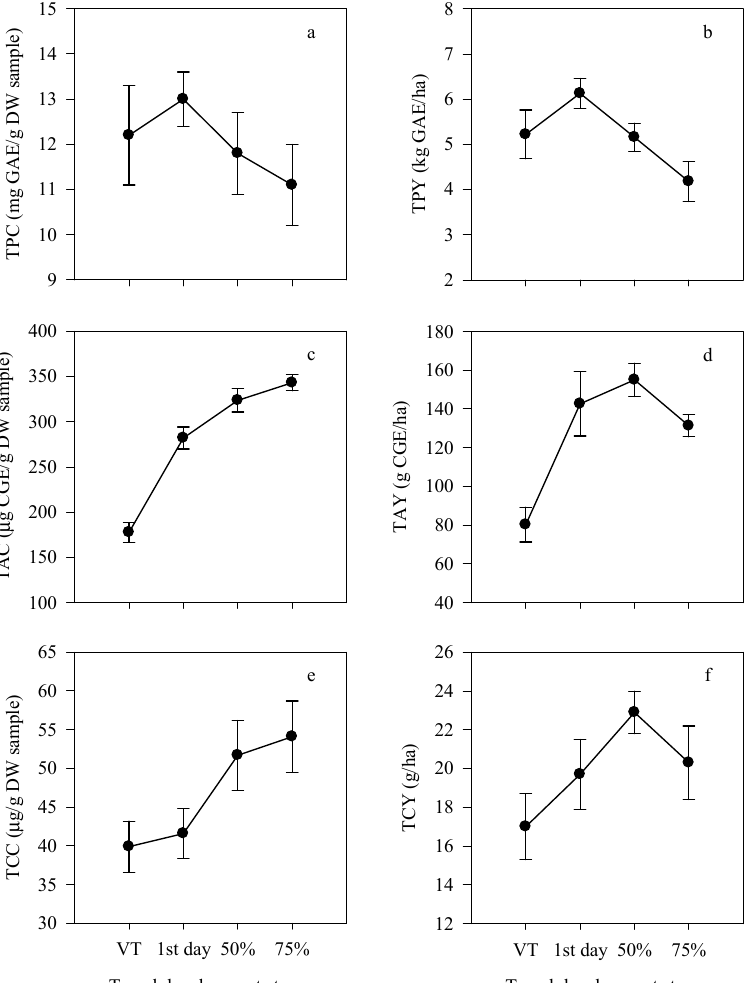
Figure 4. Effects of the corn tassel development stage on the total phenolic content ( a ), total phenolic yield ( b ), total anthocyanin content ( c ), total anthocyanin yield ( d ), total carotenoid content ( e ), and total carotenoid yield ( f ).